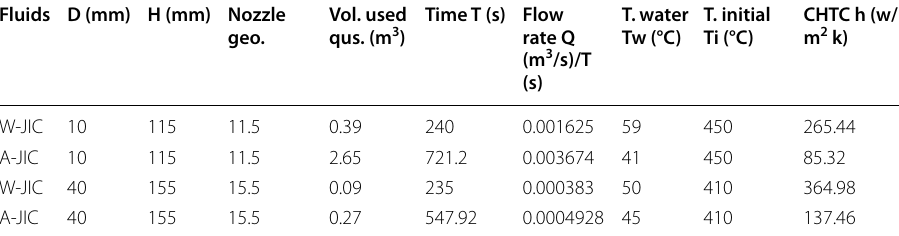
Table 8 h for D 10 and 40 mm at 150 °C and 110 °C for W-JIC and A-JIC = Fluids D (mm) H (mm) Nozzle